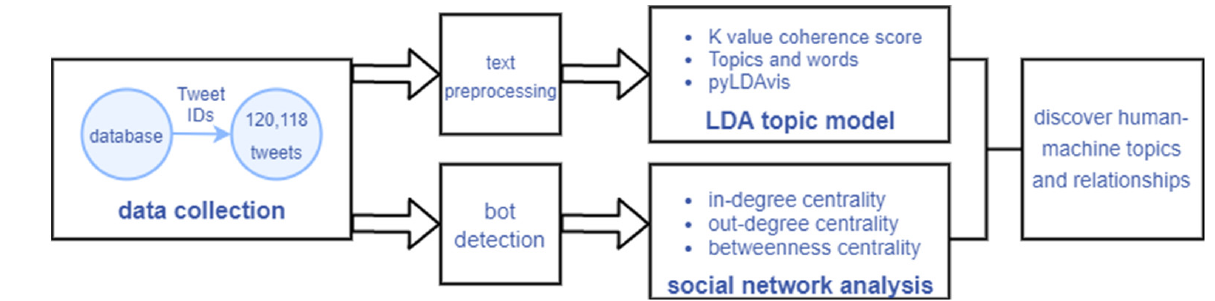
Figure 1. Steps used in this study.